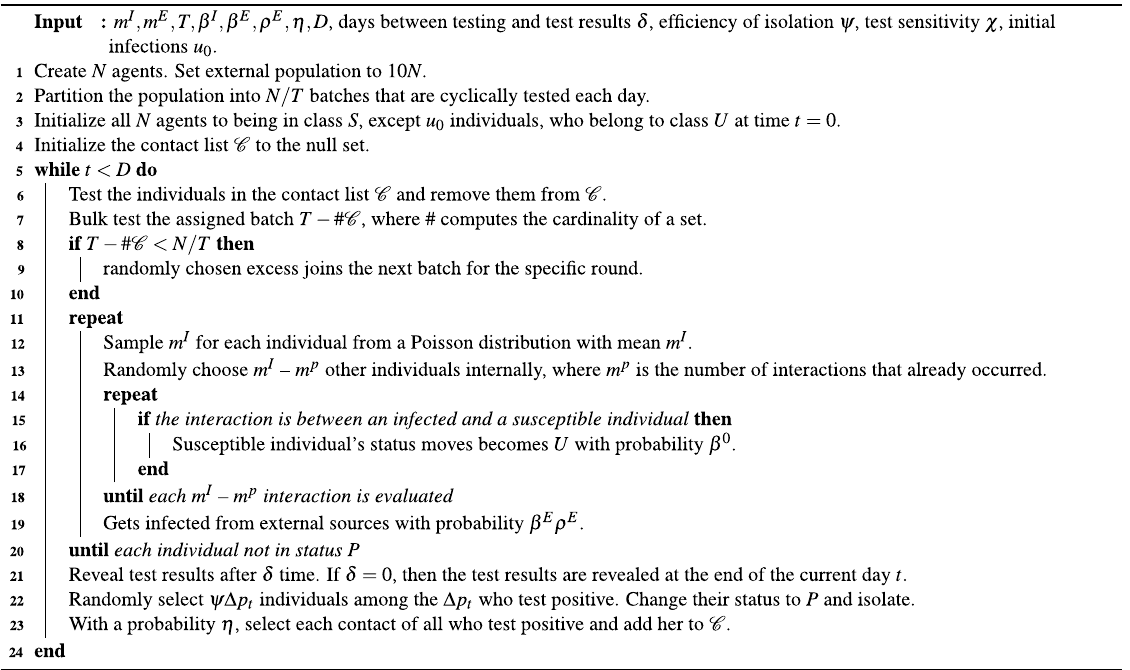
Table 1 records the results of parameter estimation from the data of the UIUC SHIELD program with 95% confidence intervals. In Fig. 2c, we present the weighted least square estimates for base infectivity β 0 starting from the fourth week (day 25) to the end of week 14. Our estimation process yields β 0 for each day, shown as a dashed black line in the figure, with a smoothed variant drawn as the blue line. The average β 0 is 0.025 with a standard deviation of 0.015. The estimates corroborate the higher infection rates around 0.1 after